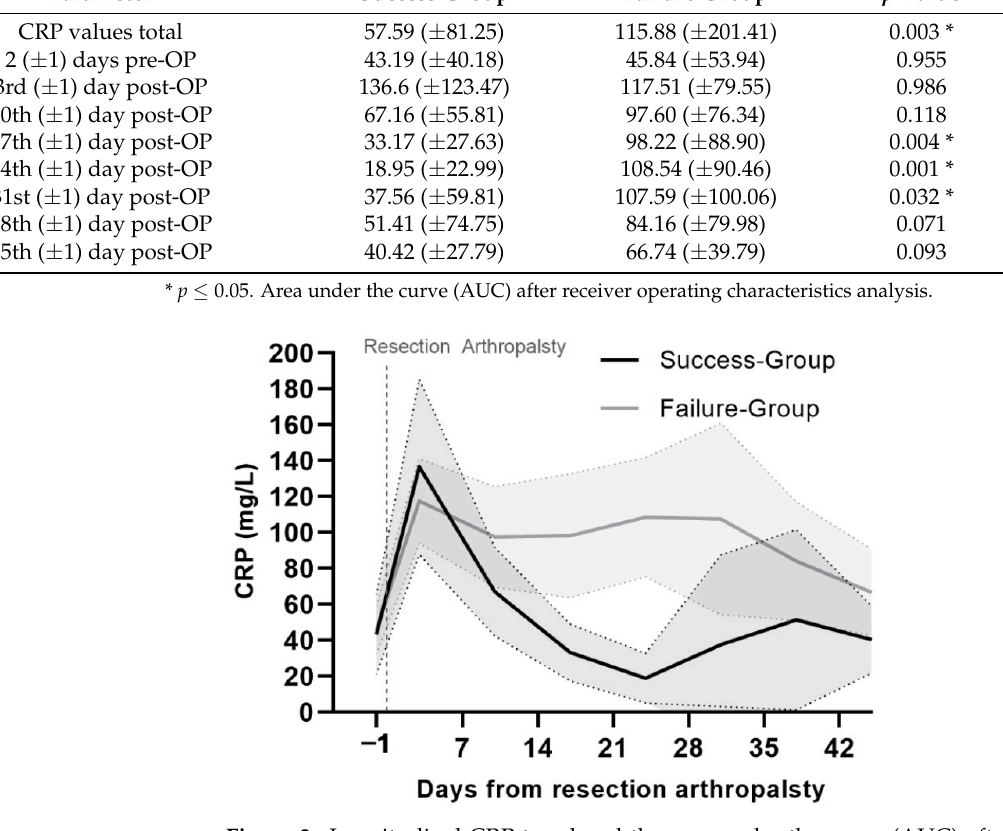
Figure 2. Longitudinal CRP trend and the area under the curve (AUC) after receiver operating characteristic (ROC) for successful (patients with reimplantation after resection arthroplasties) and failed resection arthroplasties (mean 95% CI